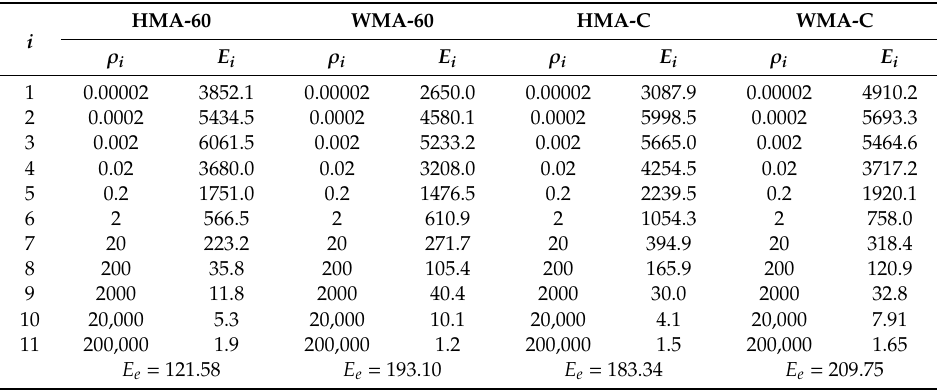
Figure A4. |𝐸(𝑆)| vs. −1/𝑆 for WMA-C. Table A3. Discrete relaxation spectrum of crumb rubber-modified asphalt mixture.